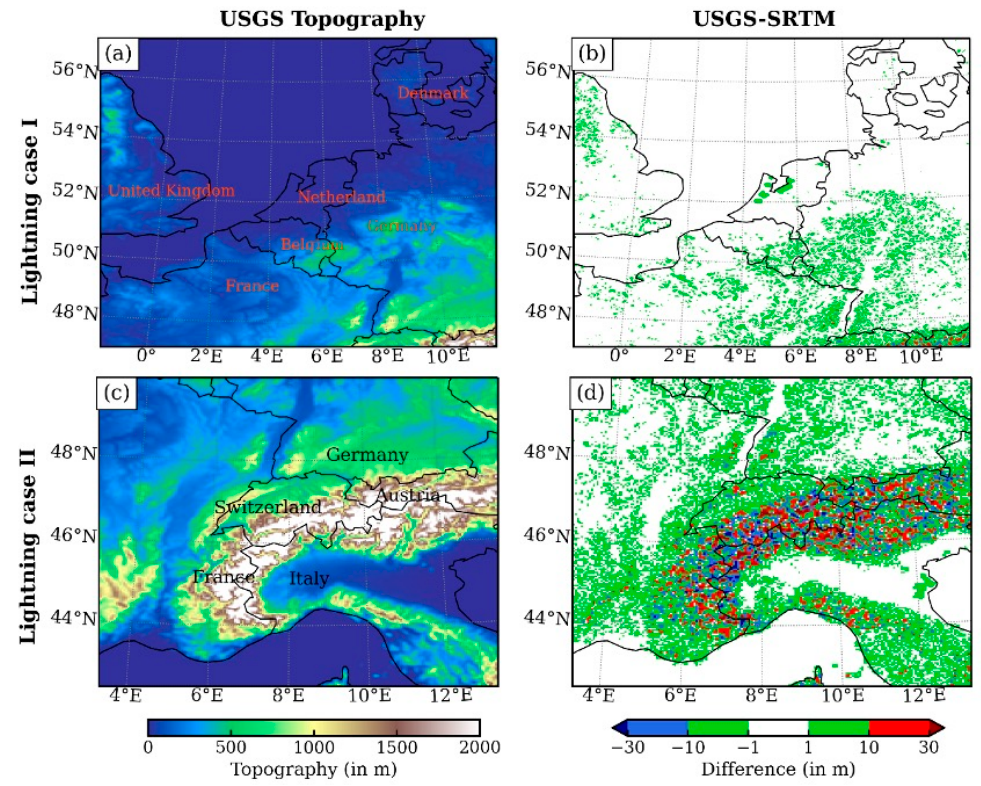
Figure 1. Area covered by the domain and variation in topographic height for ( a , b ) Case I: 18 August 2011 (first row) and ( c , d ) Case II: 29 July 2013 (second row).